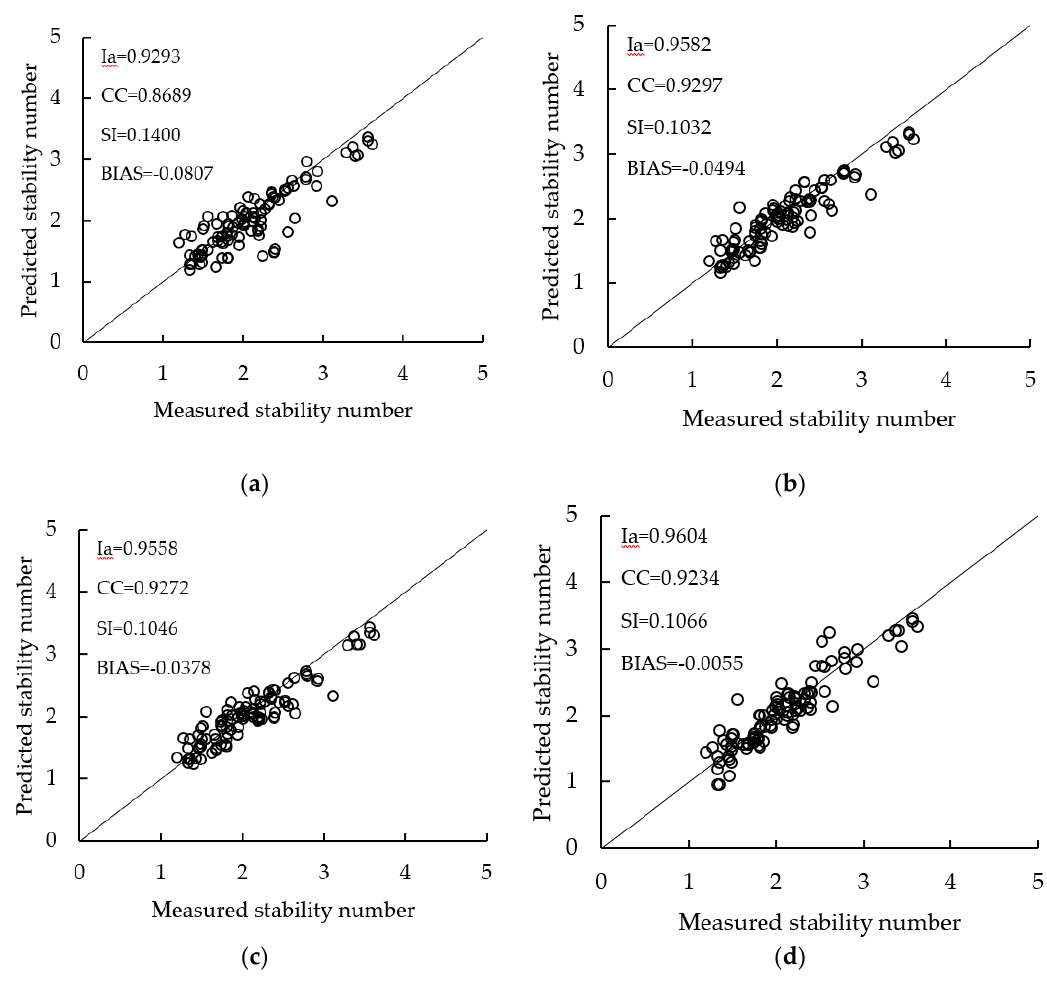
Figure 5. A performance comparison of different methods: ( a ) the van der Meer formula; ( b ) Etemad- Bonakdar formula; ( c ) GPM1 formula; and ( d ) M1 model. ( b ) Etemad-Bonakdar formula; ( c ) GPM1 formula; and ( d ) M1